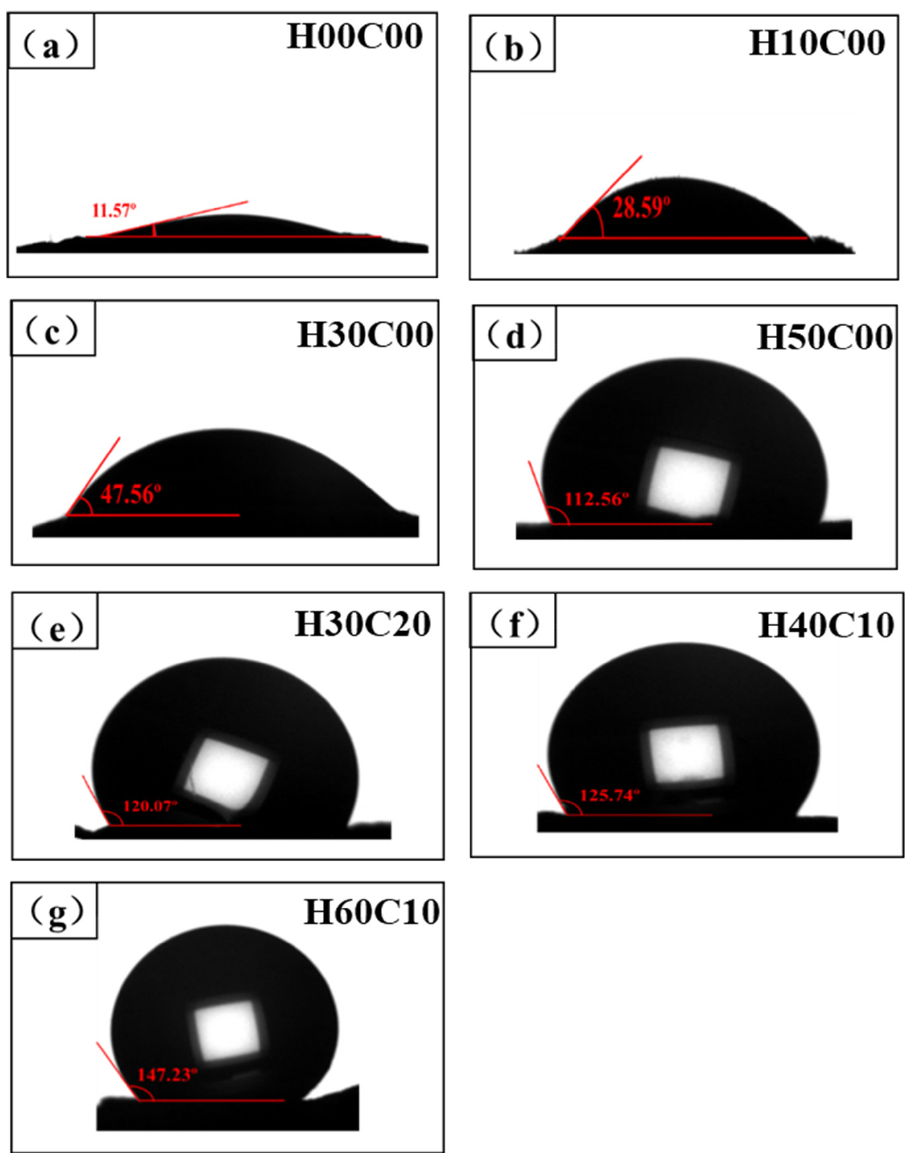
Figure 4. Influence of silicone hydrophobic agent on the phosphogypsum contact angle. ( a – g ) Inter- face contact angles of phosphogypsum blocks with different organic silicon contents.